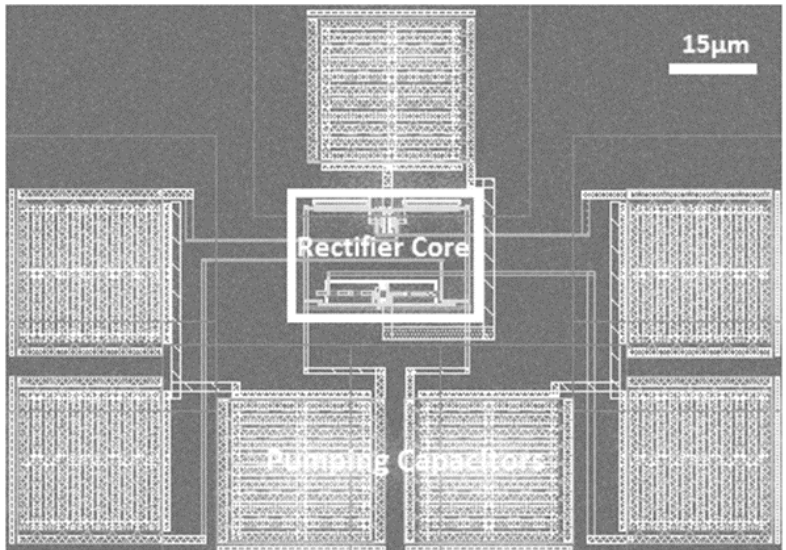
Figure 12. Chip layout of the RF CMOS rectifier prototype.